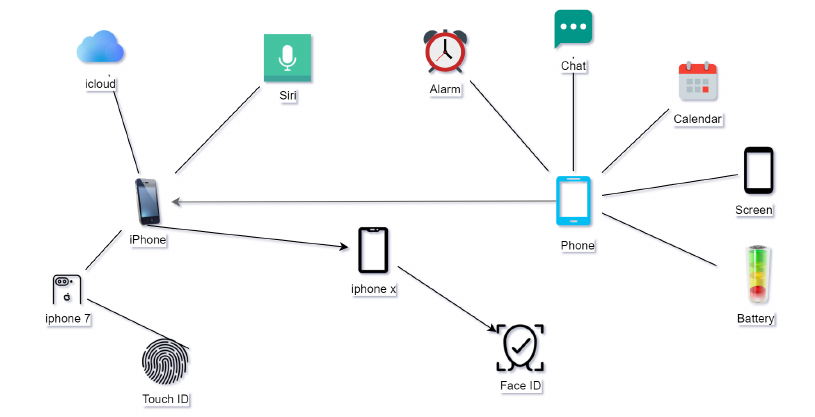
Figure A4. Entity Inherit Example for iPhone.